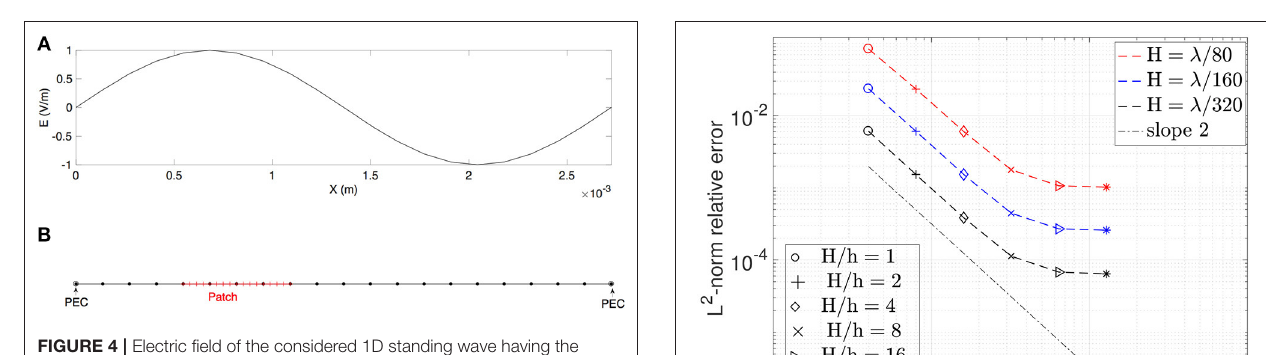
FIGURE 4 | Electric field of the considered 1D standing wave having the frequency equal to 110 GHz (A) . Example of the 1D computational domain (with perfect electrical conductor, PEC, boundary conditions) consisting of two nested Cartesian grids (B) . The patch is 10 times smaller than the coarse domain having the size equal to the wavelength λ , L = λ = 2.725 × 10 − 3 m.